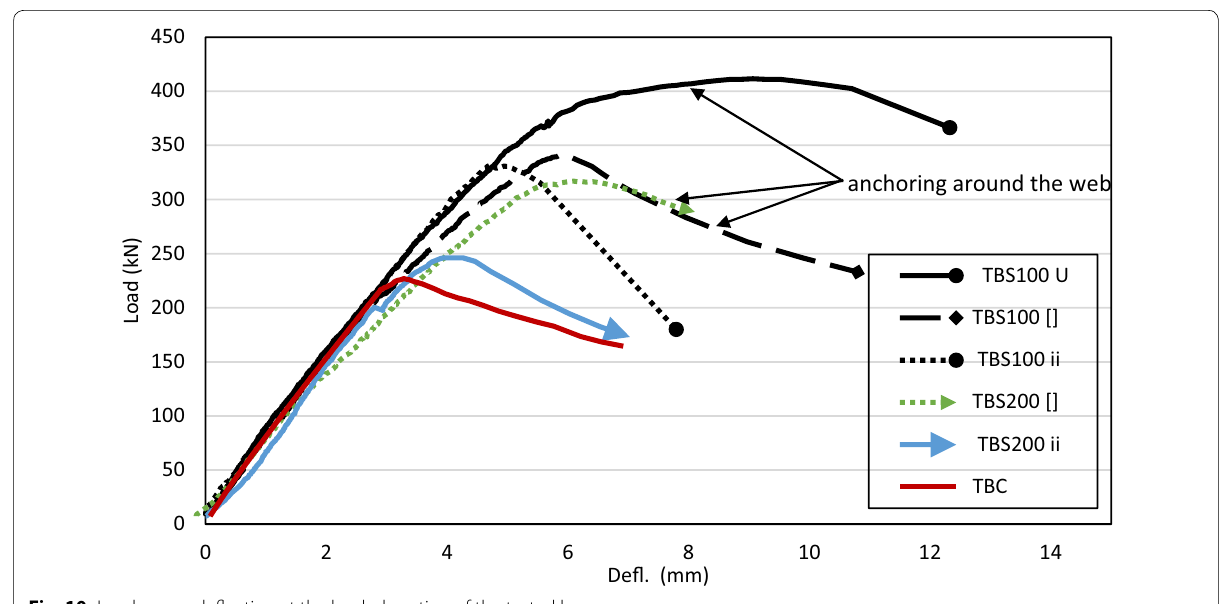
Fig. 10 Load versus deflection at the loaded-section of the tested beams.